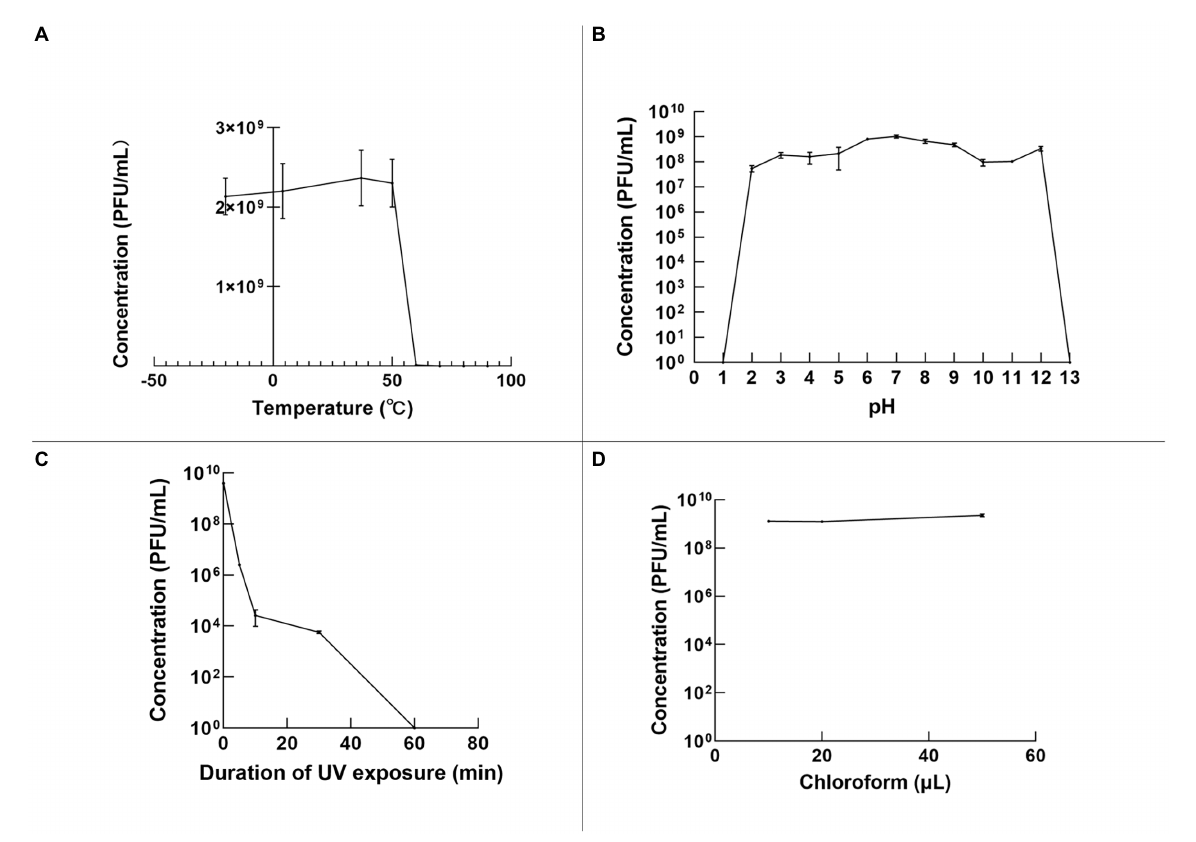
FIGURE 5 The stability of φ PaP11-13, analyzed and plotted using GraphPad Prism version 9 (A) temperature stability. (B) pH stability. (C) Ultraviolet stability. (D) Chloroform stability.